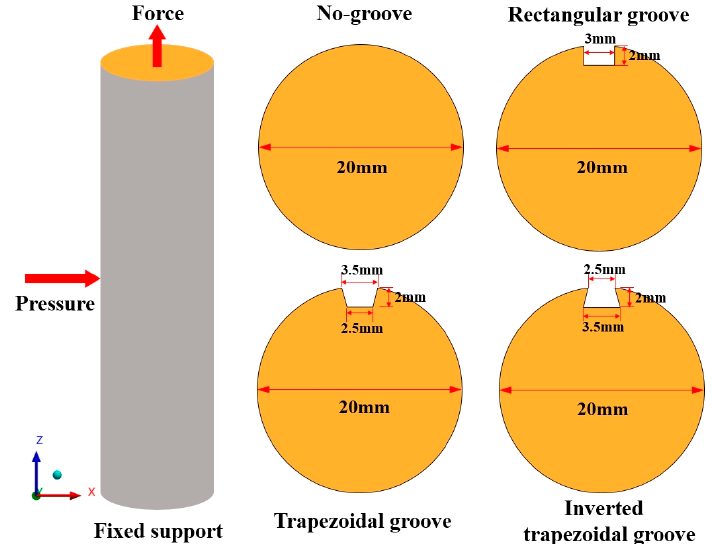
ff erent groove types and boundary Figure 3. Schematic diagram of different groove types and boundary conditions. Figure 3. Schematic diagram of di